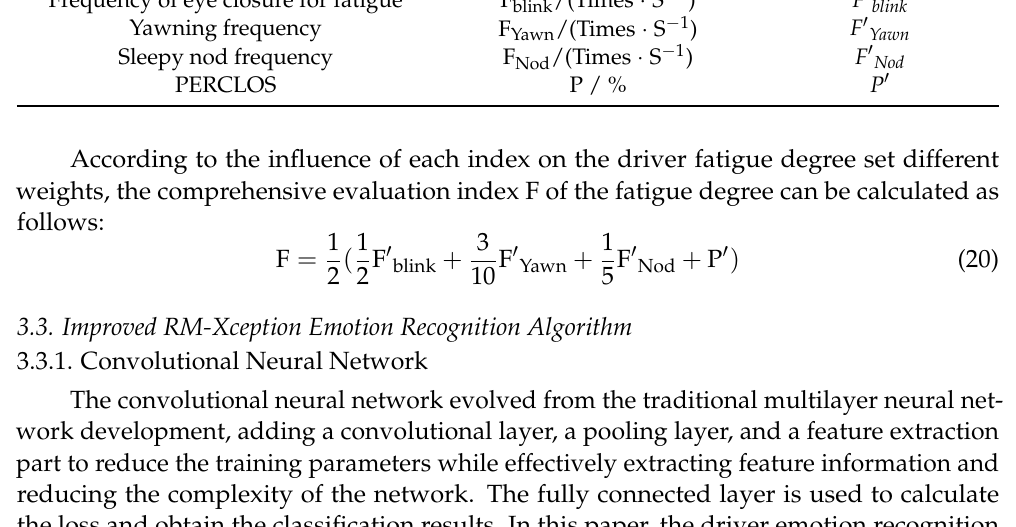
Table 1. Fatigue indicators. Fatigue